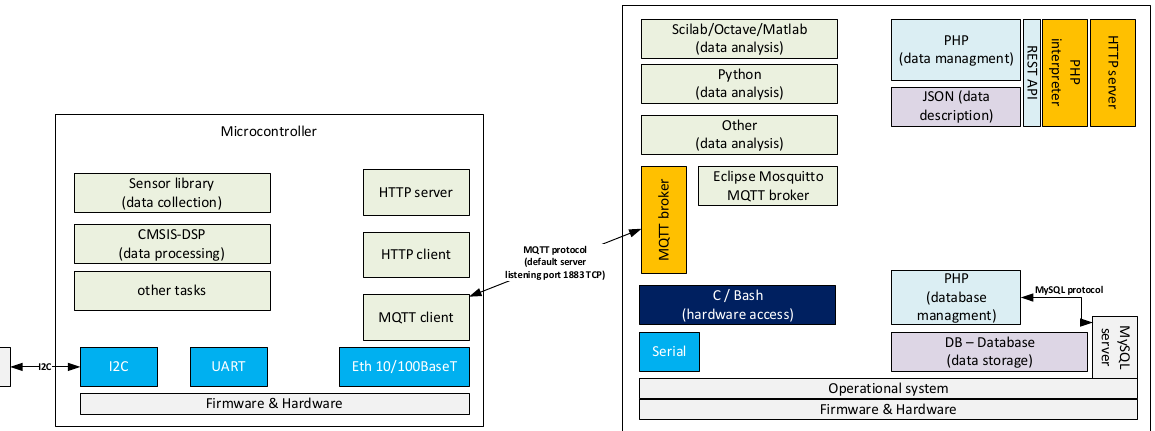
Figure 7. MQTT 3.1 client–server architecture.